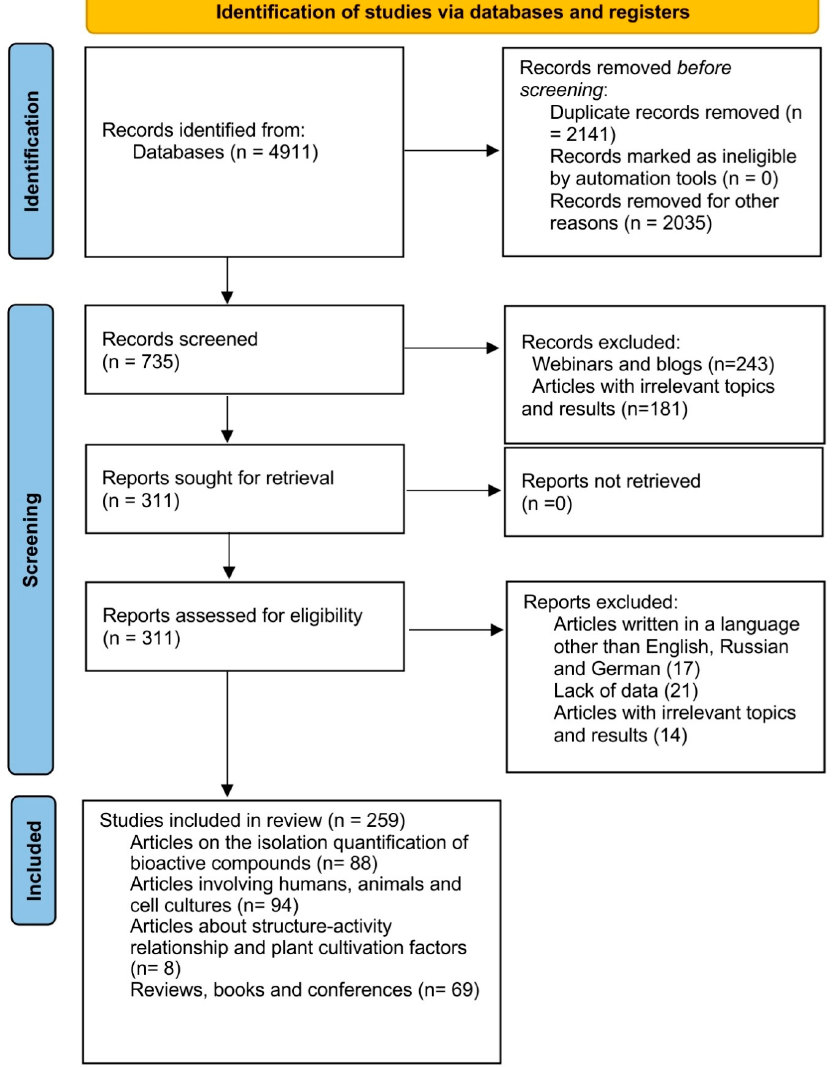
Figure 1. PRISMA 2020 flow diagram [21].